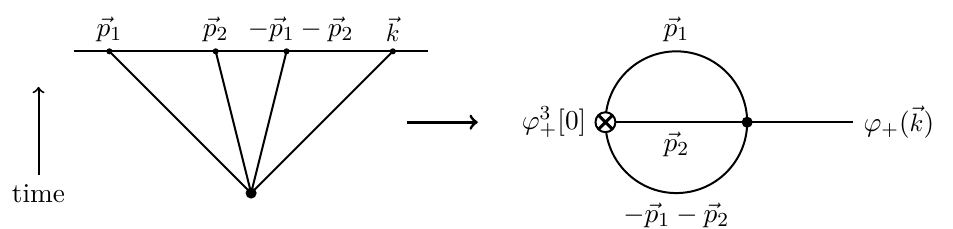
→ ϕ + . We start from + . +